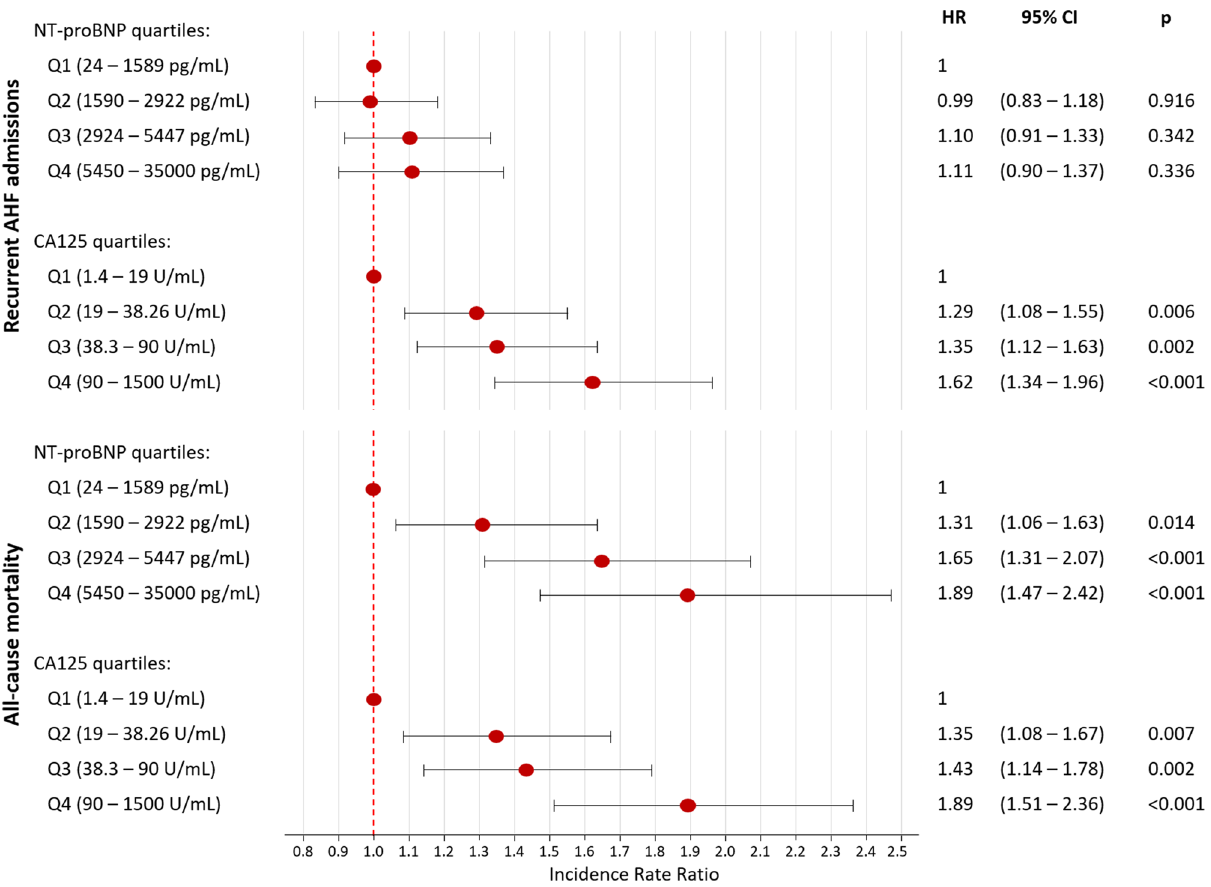
Figure 2. Risk of AHF recurrent hospitalizations and all-cause mortality among NT-proBNP and CA125 quartiles. AHF: acute heart failure; CA125: carbohydrate antigen 125; NT-proBNP: amino-terminal pro-brain natriuretic peptide.